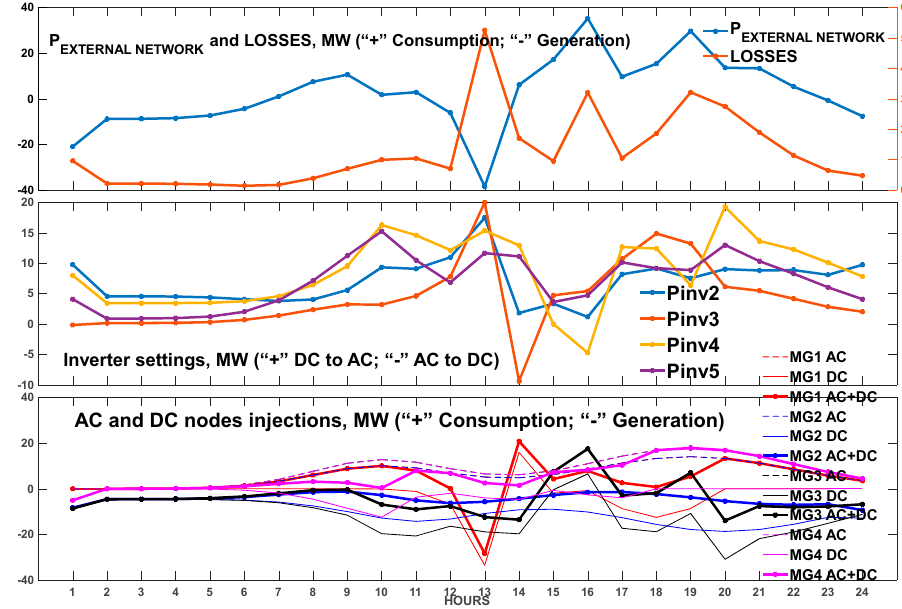
Figure 11. Operational control of the test system using the proposed two ‐ level algorithm.